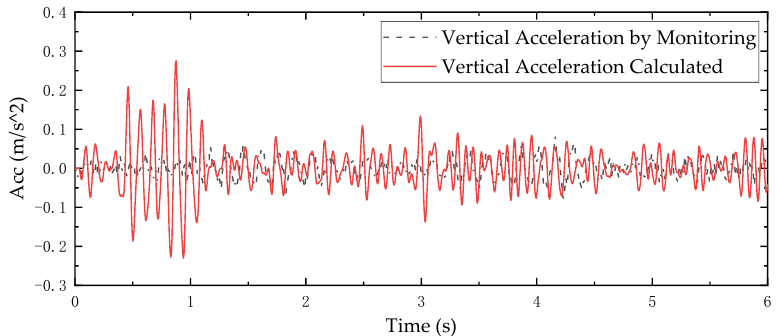
Figure 21. Comparison of vertical acceleration between measurement and simulation results of 3AS-02.